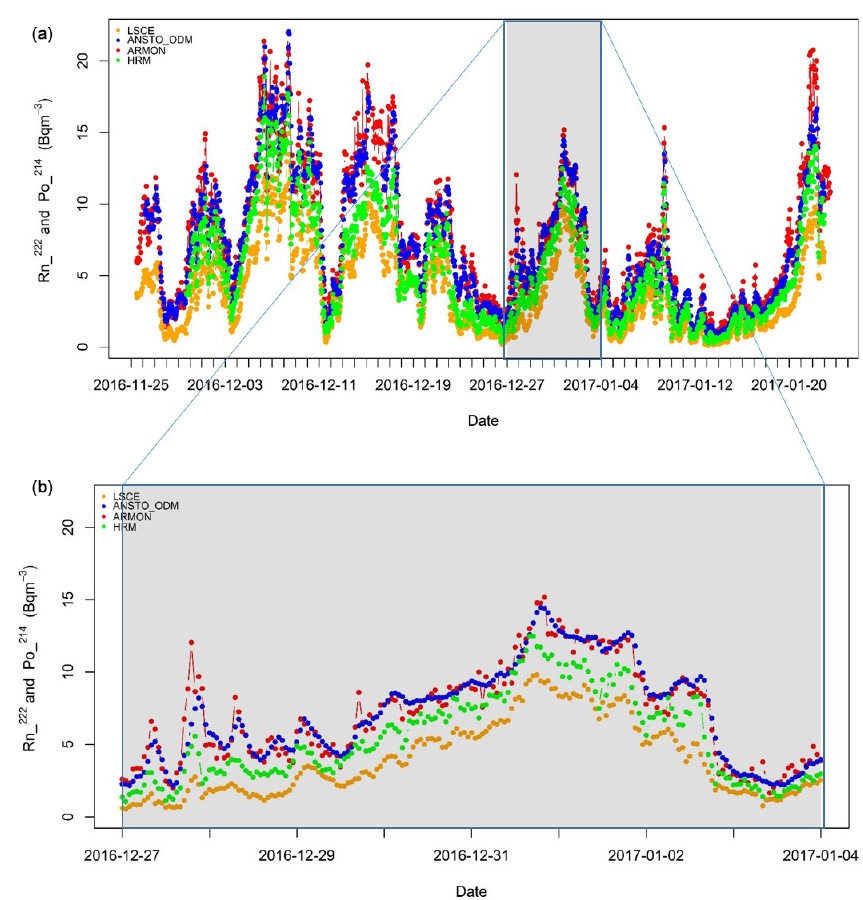
Figure 2. (a) Hourly time series of the atmospheric 222 Rn and, in the case of LSCE and HRM data, 214 Po activity concentration, measured at the Orme de Mérisiers (ODM) station during Phase I (between 25 November 2016 and 23 January 2017) by the ARMON (red circles), ANSTO_ODM (blue circles), HRM (green circles), and LSCE (orange circles) monitors. (b) Hourly time series of the atmospheric 222 Rn and 214 Po measured between 27 December 2016 and 4 January